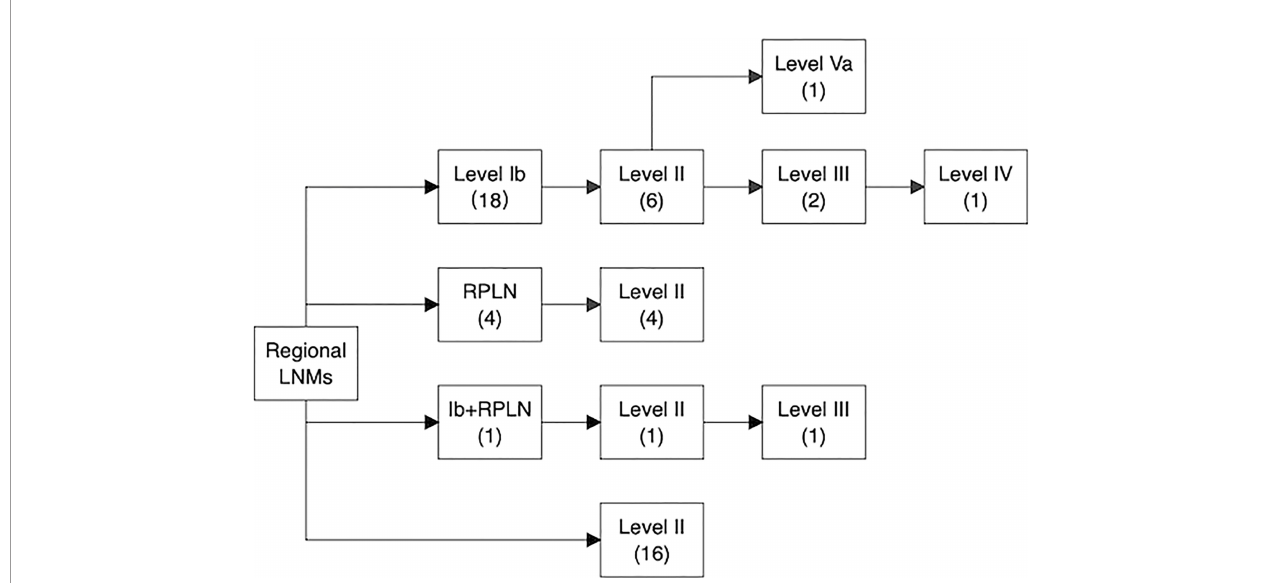
FIGURE 5 | Pathways of ipsilateral lymph node spread in SNSCC. The number in the bracket represents the number of patients who had nodal involvement in speci fi c lymph node